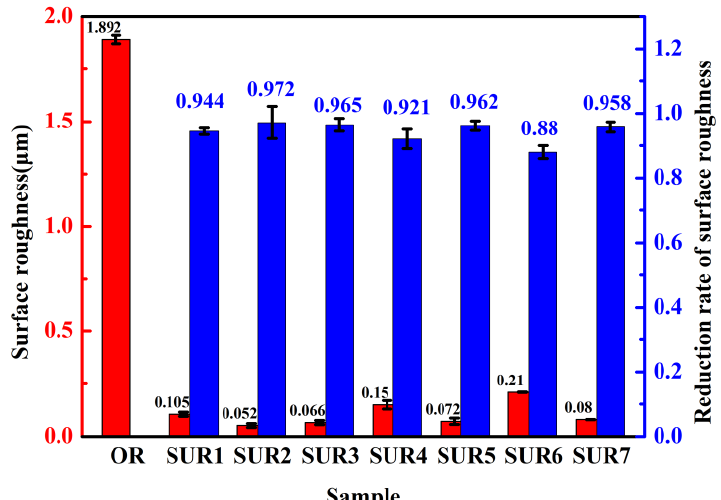
Figure 4. Surface roughness and roughness reduction rate before and after rolling.